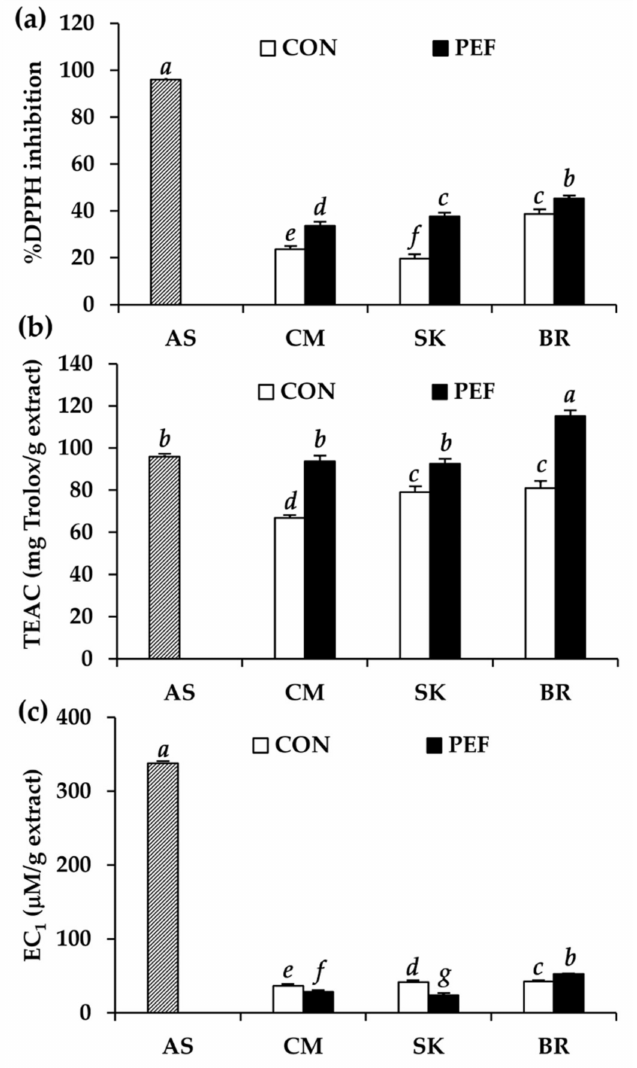
Figure 4. ( a ) DPPH • inhibition, ( b ) ABTS • + inhibition, and ( c ) ferric reducing antioxidant power of ascorbic acid (AS) and M. alba leaf extract from Chiang Mai (CM), Sakon Nakhon (SK), and Buriram (BR) expressed as % inhibition, Trolox equivalent antioxidant capacity (TEAC), and equivalent